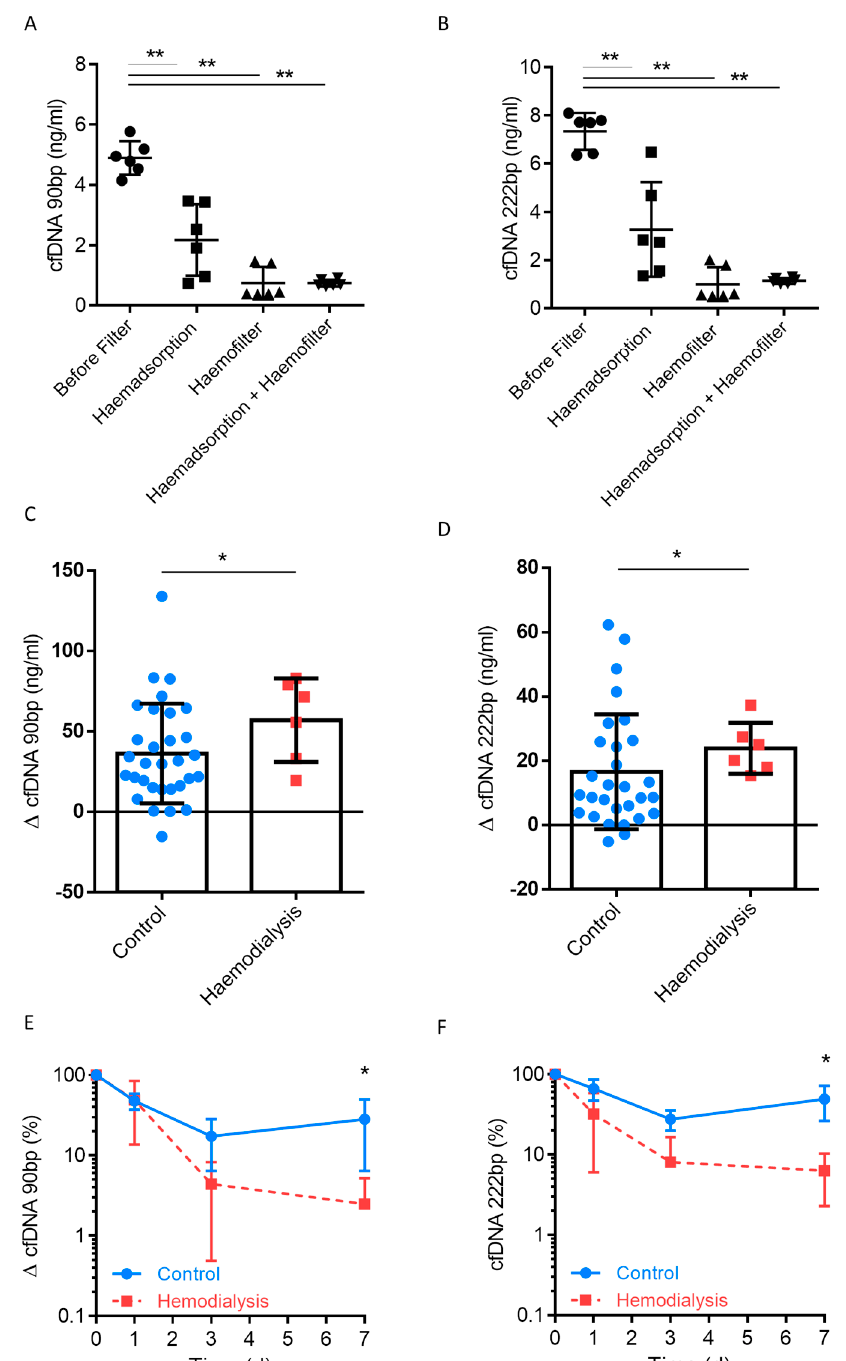
Figure 6. ( A , B ) A fully-equipped haemodialysis instrument was setup without connecting it to a patient, cfDNA was added to the arterial inflow, and cfDNA levels were determined in the fluid from the tubing system (where blood normally flows through) before the filter (control), after the Cytosorb haemadsorption column (CytoSorbents, New Jersey, NJ, USA), after the AV 1000s Ultraflux haemofilter (Fresenius Medical Care, Bad Homburg, Germany), and after both combined. Patients after liver transplantation ( n = 50) grouped based on continuous veno-venous haemofiltration, which was performed on at least 3 days within the first 7 days postoperatively. Differences in cfDNA were subsequently determined. ( C , D ) Relative levels of cfDNA following haemodialysis. ( E , F ) Measurement of cfDNA in serum in 50 patients after liver transplantation (L1PA2 element, 90 bp and 222 bp, LINE sequence, non-coding). Mann–Whitney U test; * p < 0.05; ** p < 0.01.